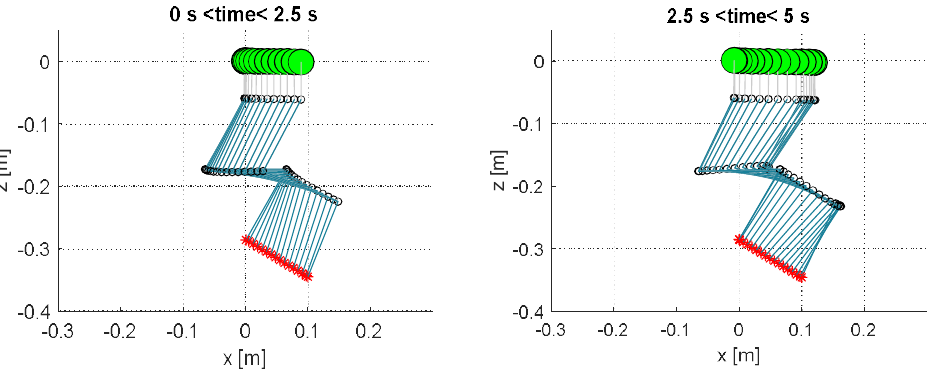
Figure 12. Stroboscopic trajectories for the first half ( left ) and second half ( right ) of the linear trajectory task for the 3-DOF redundant UAM using the generalized Jacobian with external forces. The UAV base is the large green marker, joints are the black circles, links are the blue lines, and end-effector positions tracked are the red crosses.